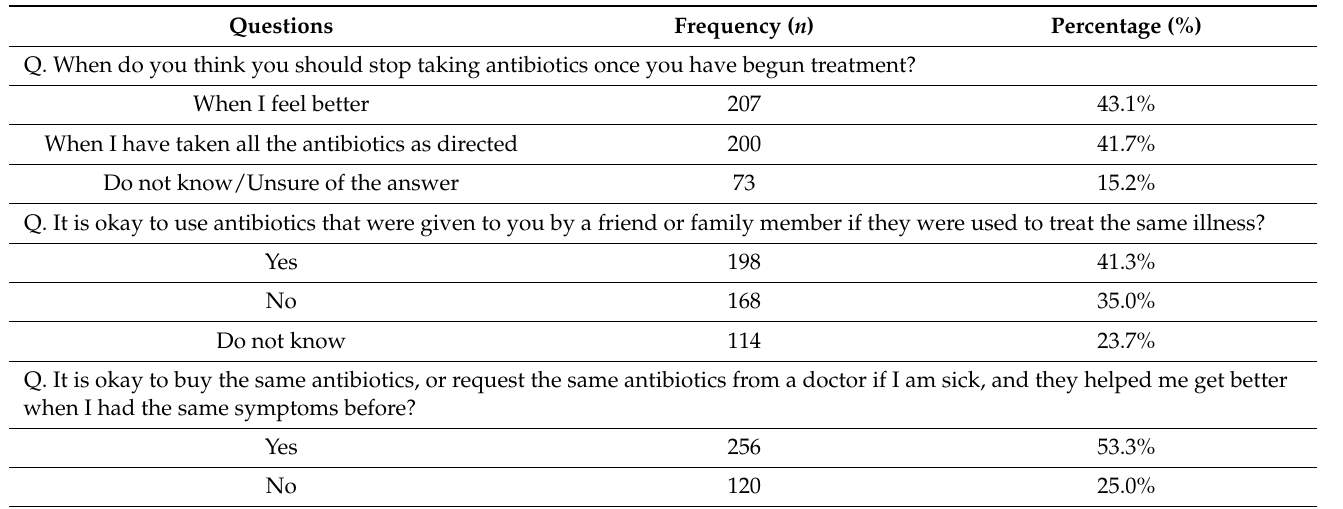
Table 3. The participants’ responses regarding the knowledge and attitude